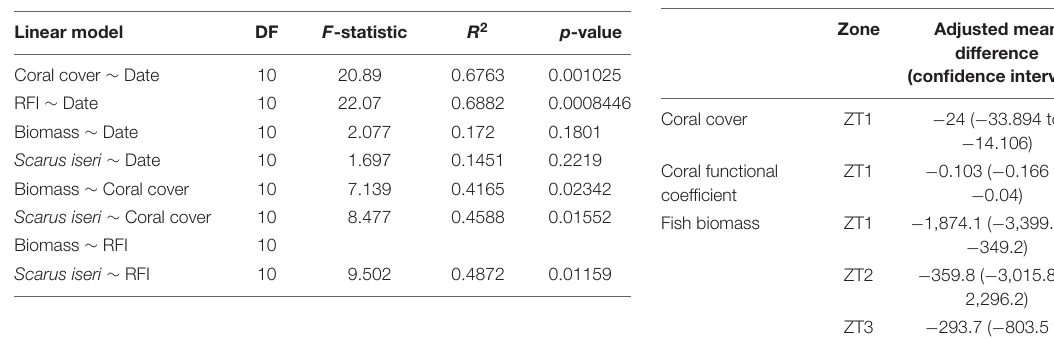
TABLE 6 | Ecological cost due hurricanes in three outplanting sites and one control.